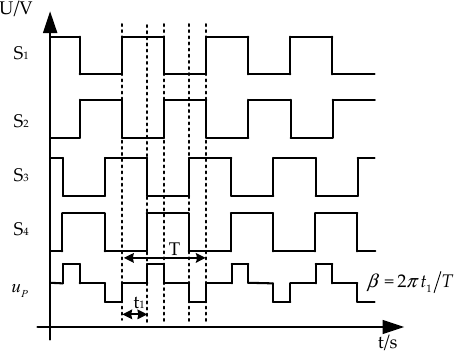
Figure 2. MOSFET control signals in a full-bridge inverter ( β is the phase-shifting angle).